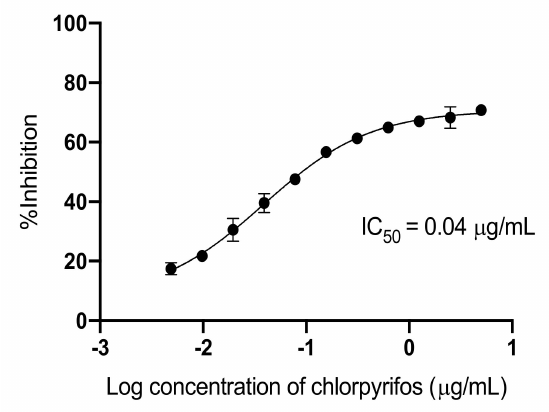
Figure 2. Standard curve of organophosphate pesticide chlorpyrifos by optimized ic-ELISA. The coating antigen was (c)-ova 1 µ g / ml, and the serum dilution was